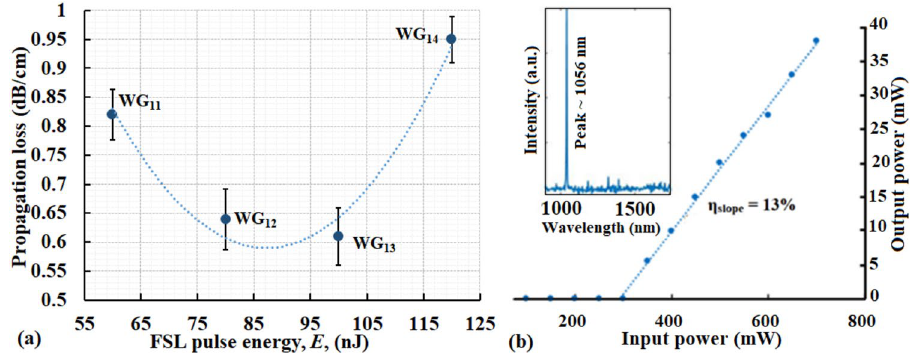
Figure 10. ( a ) PL in the 5 MHz inscribed WGs as a function of the FSL pule energy. ( b ) 1056 nm laser operation in WG 12 with max. η slope = 13% slope efficiency and P threshold ~ 250